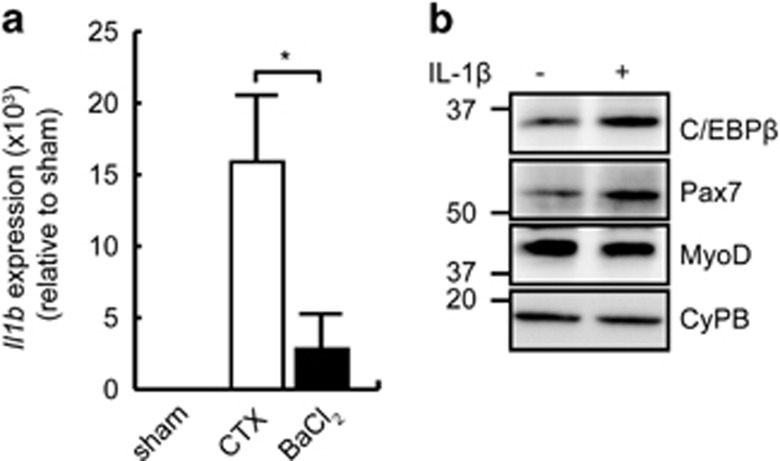
Il-1β upregulates C/EBPβ expression. (a) Il1b expression in whole TA muscle 24 h after injury with CTX or BaCl2. Sham injury was performed with PBS. n=5, *P<0.05. (b) Western analysis of C/EBPβ, Pax7 and MyoD protein expression in primary myoblasts incubated with IL-1β for 24 h in growth medium. The migration of molecular weight markers, in kDa, is shown. Cyclophilin B (CyPB) is a loading control